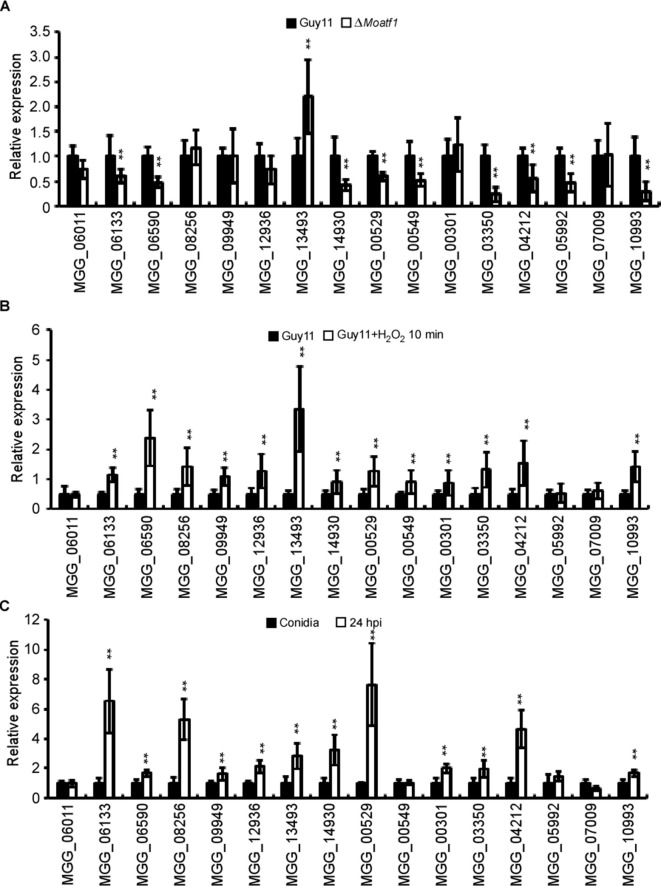
Expression levels of the oxidation regulatory pathway genes in the ∆Moatf1 mutant.(A) The relative expression levels of putative oxidation regulation pathway genes in ∆Moatf1 mutant were analyzed by qRT-PCR and normalized to that of ACTIN. Error bars represent the standard deviations and asterisks represent significant differences (p<0.01). (B) The relative expression levels of putative oxidation regulation pathway genes with H2O2 treatment for 10 min were analyzed by qRT-PCR and normalized to that of ACTIN. Error bars represent the standard deviations and asterisks represent significant differences (p<0.01). (C) The relative expression levels of putative oxidation regulation pathway genes in conidia and 24 hpi were analyzed by qRT-PCR and normalized to that of ACTIN. Error bars represent the standard deviations and asterisks represent significant differences (p<0.01).